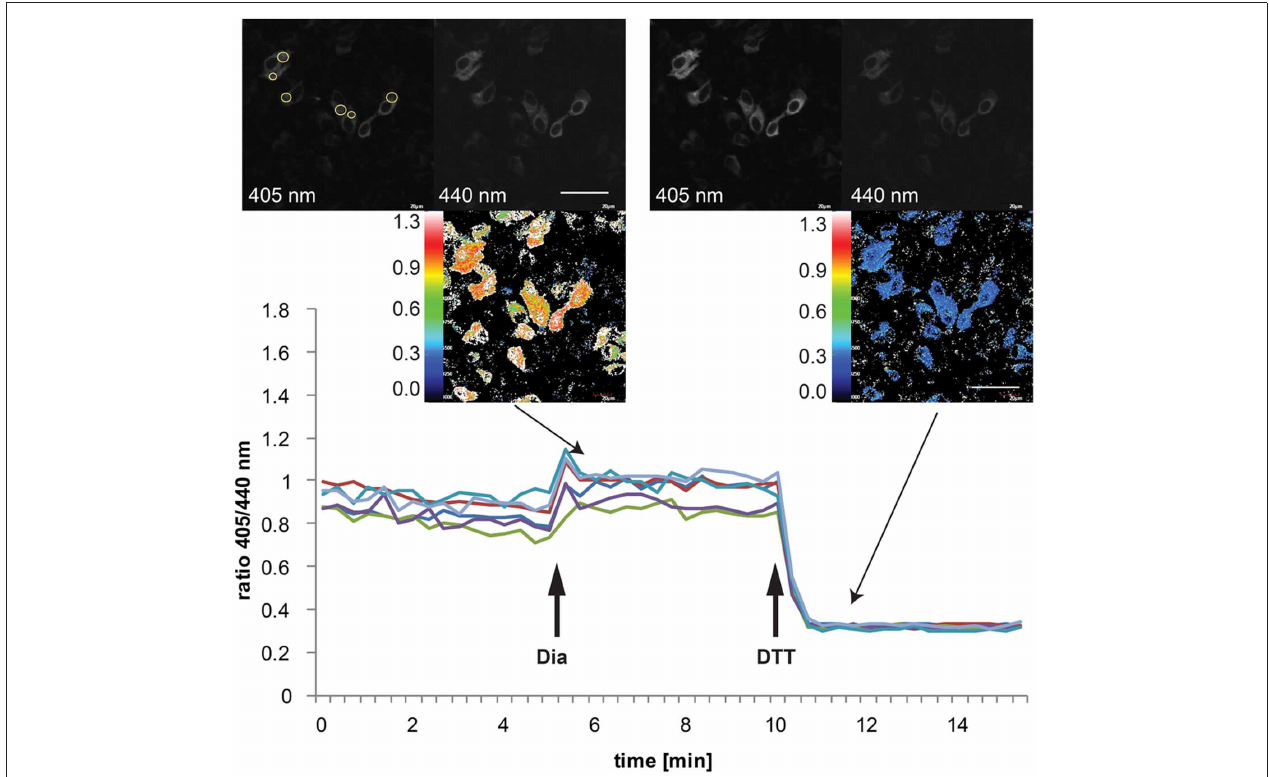
FIGURE 3 | Imaging of dynamic changes in the Grx1-roGFP1-iE ER excitation ratio in transiently transfected HeLa cells. HeLa cells were seeded to MatTek glass bottom dishes and transfected on the following day with Grx1-roGFP1-iE ER . Forty eight hours post-transfection, the cells were analyzed by ratiometric laser scanning microscopy. The dynamic changes of the ratios of emission intensities (405nm excitation):(440nm excitation)